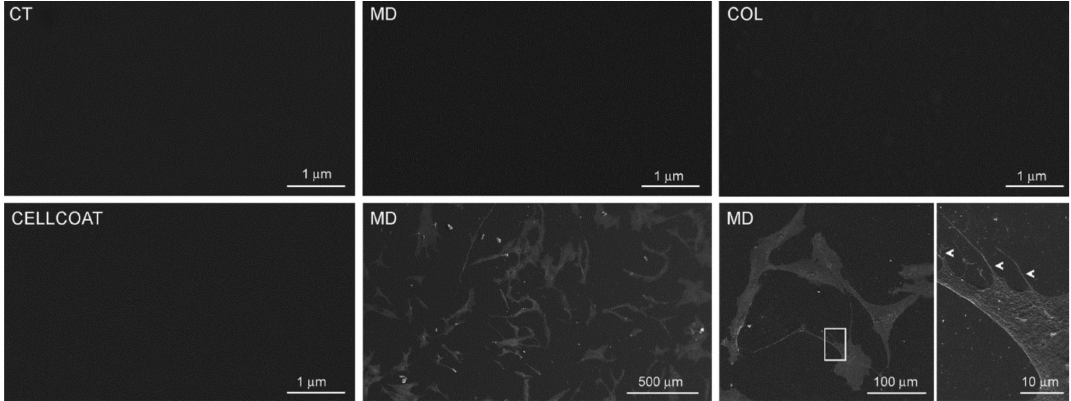
Figure 3. Scanning electron microscopy (SEM) images of Petri dish uncoated (CT) or coated with MD-Tissue (MD) or collagen (COL) solution. An SEM image of a commercial Petri dish coated with Type I collagen (CELLCOAT Type I Collagen—Greiner bio-one cod.628950) is also shown. SEM images of human tenocytes cultured on an MD Tissue-coated Petri dish at low (left) and high magnification (right); in the inset at higher magnification, the thin flattened processes extending from the cell body (arrowheads) are visible. The scale bar is shown in the bottom right corner of each